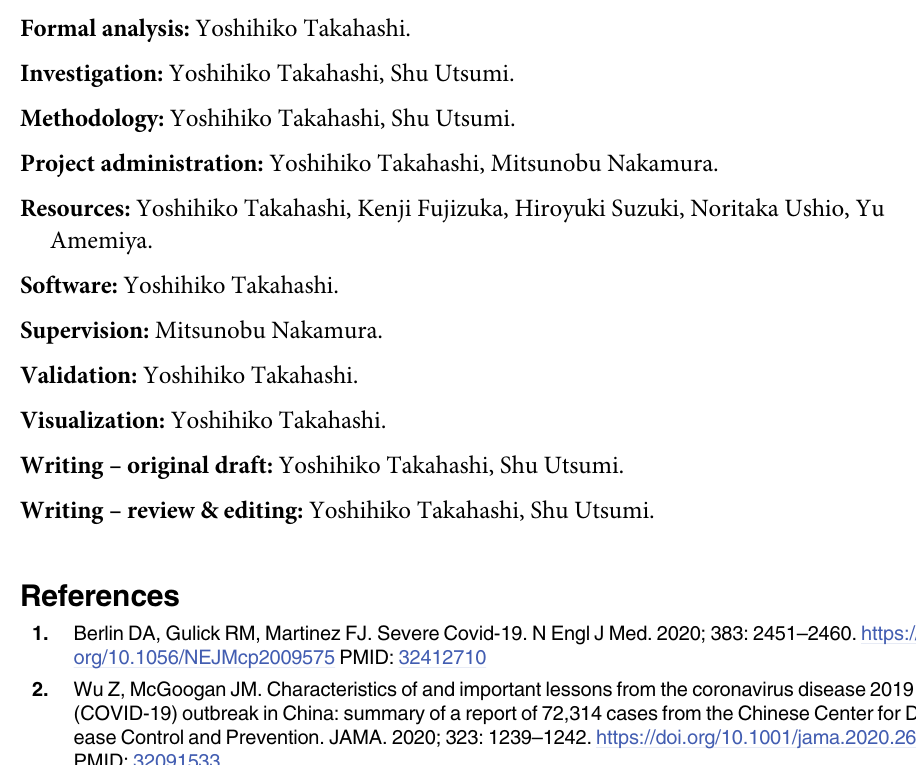
based on previous reports regarding the frequency of VAP occurrence due to the causative bacteria and used it until the patient was extubated [20]. S4 Table. Multiple linear regression analysis of duration of ventilation. The multivariable analysis was conducted with age, sex, and sequential organ failure assessment (SOFA): these are considered risk factors for severe coronavirus disease 2019 (COVID-19) pneumonia. The duration of ventilation was log-transformed before the multivariate analysis. The pre-intro- duction group included 17, and the post-introduction group included 50 patients. S5 Table. Multiple linear regression analysis of length of intensive care unit (ICU) stay. The multivariable analysis was conducted with age, sex, and sequential organ failure assess- ment (SOFA): these are considered risk factors for severe severe coronavirus disease 2019 (COVID-19) pneumonia. The length of ICU stay was log-transformed before the multivariate analysis. The pre-introduction group included 18 patients, and the post-introduction group included 50